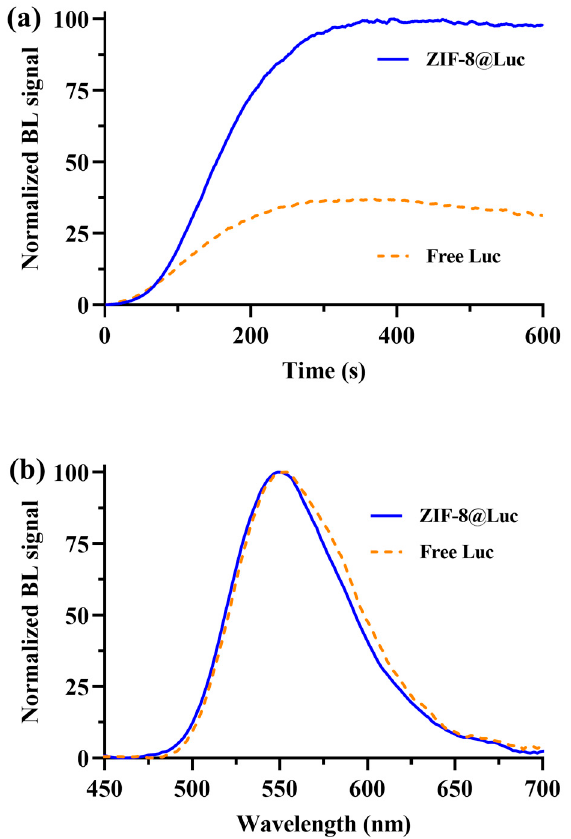
Figure 3. Characterization of the bioluminescence (BL) emission properties of ZIF-8@Luc paper sensor in comparison with the free luciferase mutant obtained with a benchtop luminometer with acquisition 10 min after D-LH 2 automatic injection: ( a ) BL kinetics; ( b ) BL emission spectra obtained with ZIF-8@Luc sensor and free luciferase mutant in the same conditions.